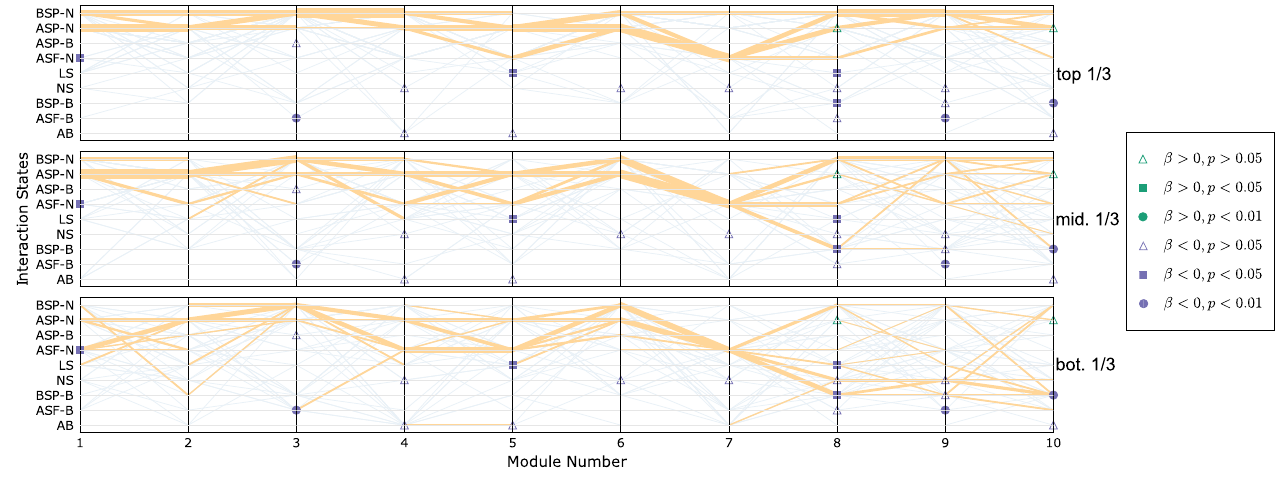
FIG. 5. Parallel coordinate graphs using level III (nine) states.